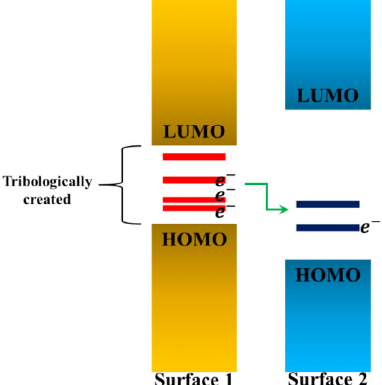
Fig. 3 Tribologically induced non-equilibrium states to accommodate and aid charge transferring in two surfaces (mainly insulating